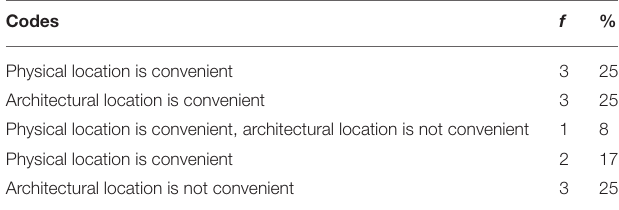
TABLE 1 | Views on the physical and architectural location of the